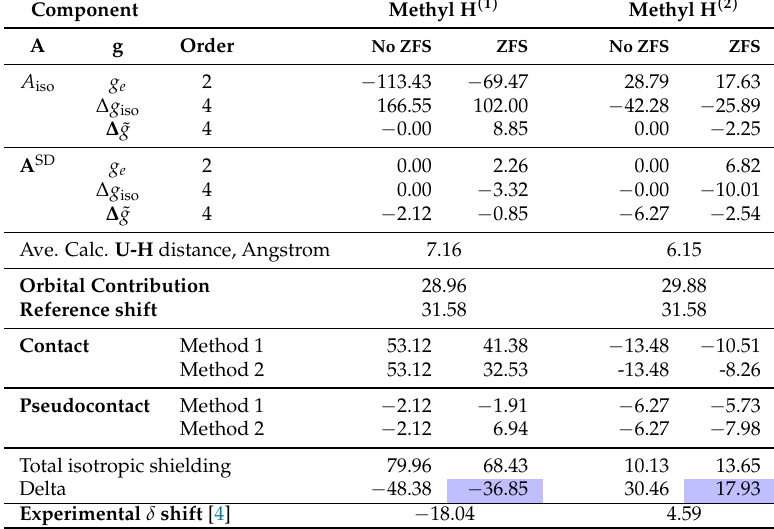
Figure 5. Experimental and predicted pNMR shifts of U(MeBTP) 3 + For numbering of protons see Figure 3. The order is consistent in all cases. Table 6. Calculated 1 H pNMR shifts for the methyl H atoms of U(MeBTP) 3 + For numbering of protons see Figure 3. The final, ZFS corrected, computational values are